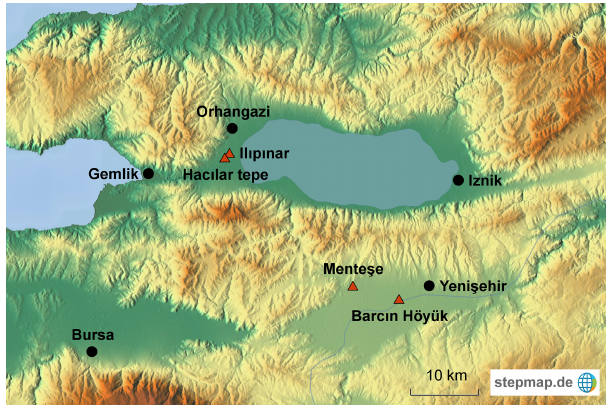
Figure 8. Archaeological settlements (red triangles) in the vicinity of Lake